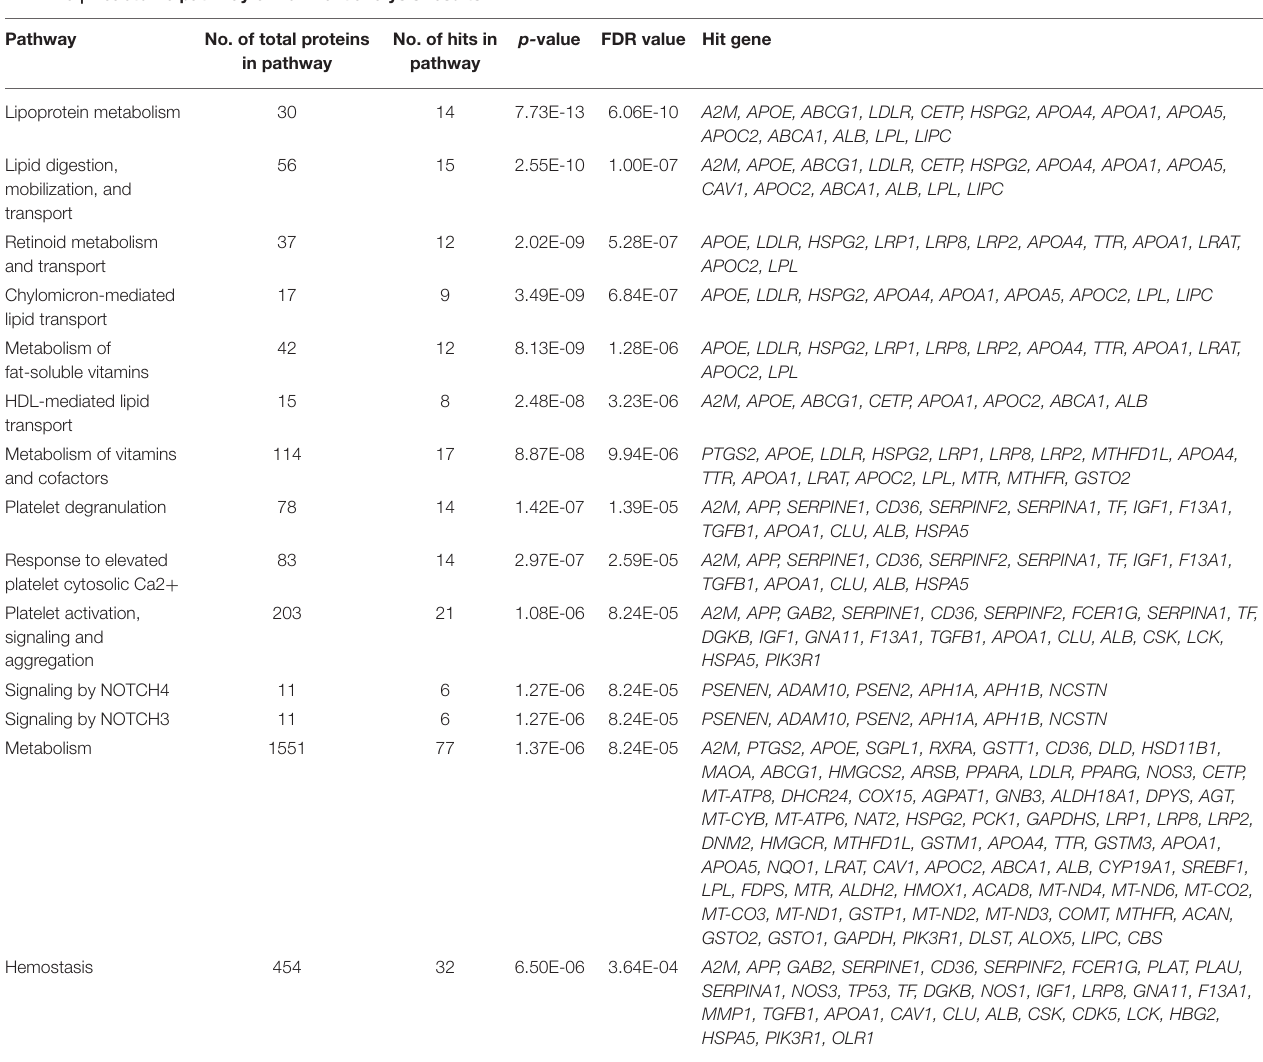
TABLE 5 | Reactome pathway enrichment analysis